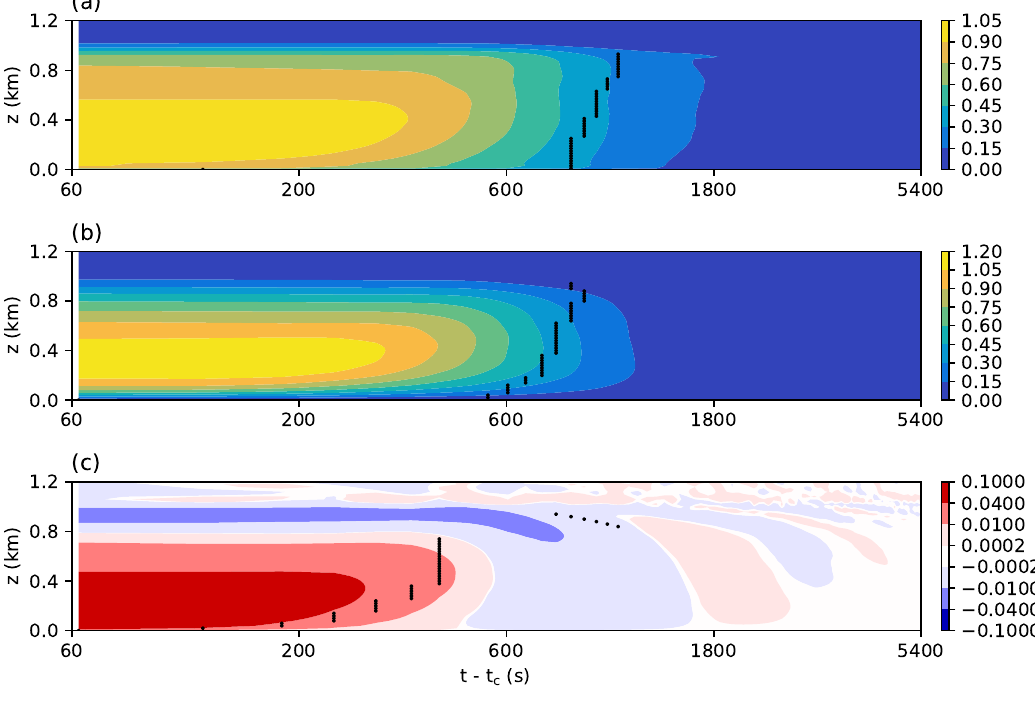
Figure 5. Time series of vertical profiles of ( a ) TKE, ( b ) vertical velocity variance, and ( c ) vertical heat flux. The horizontal axis indicates the time after the cutoff of surface heat flux and it is in logarithmic scale to highlight the initial decay. The black dots indicate the e -folding decay times below z = z i